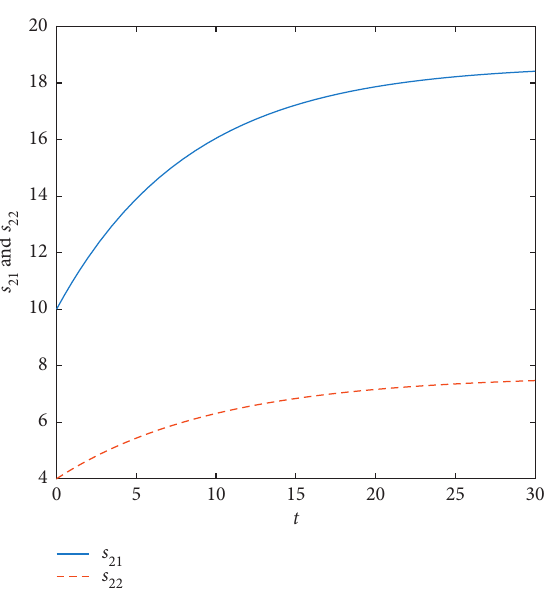
Figure 17: The pollution stock trajectory of both regions under noncooperation and cooperation.